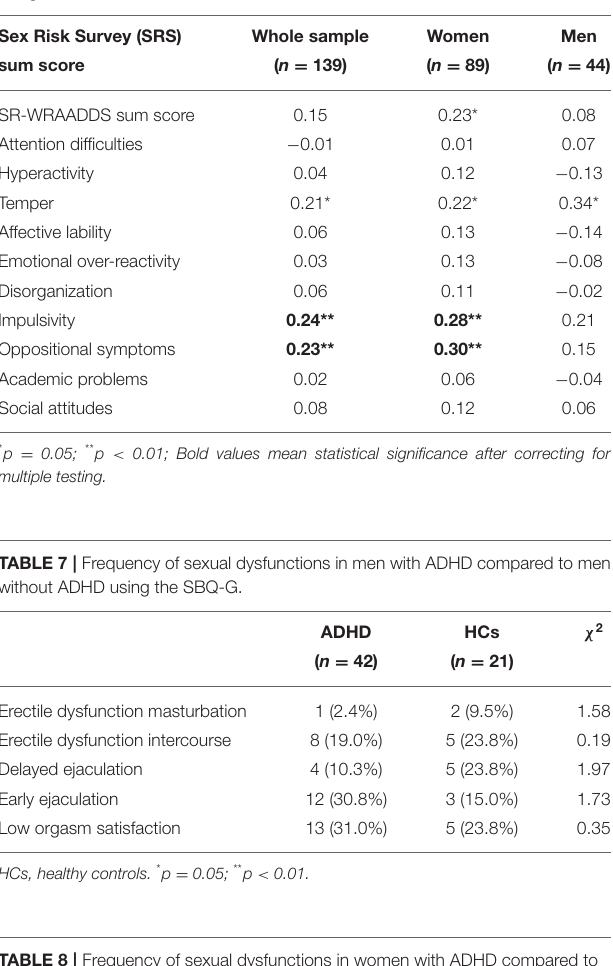
TABLE 6 | Association between ADHD symptomatology and overall risk score using the SRS.